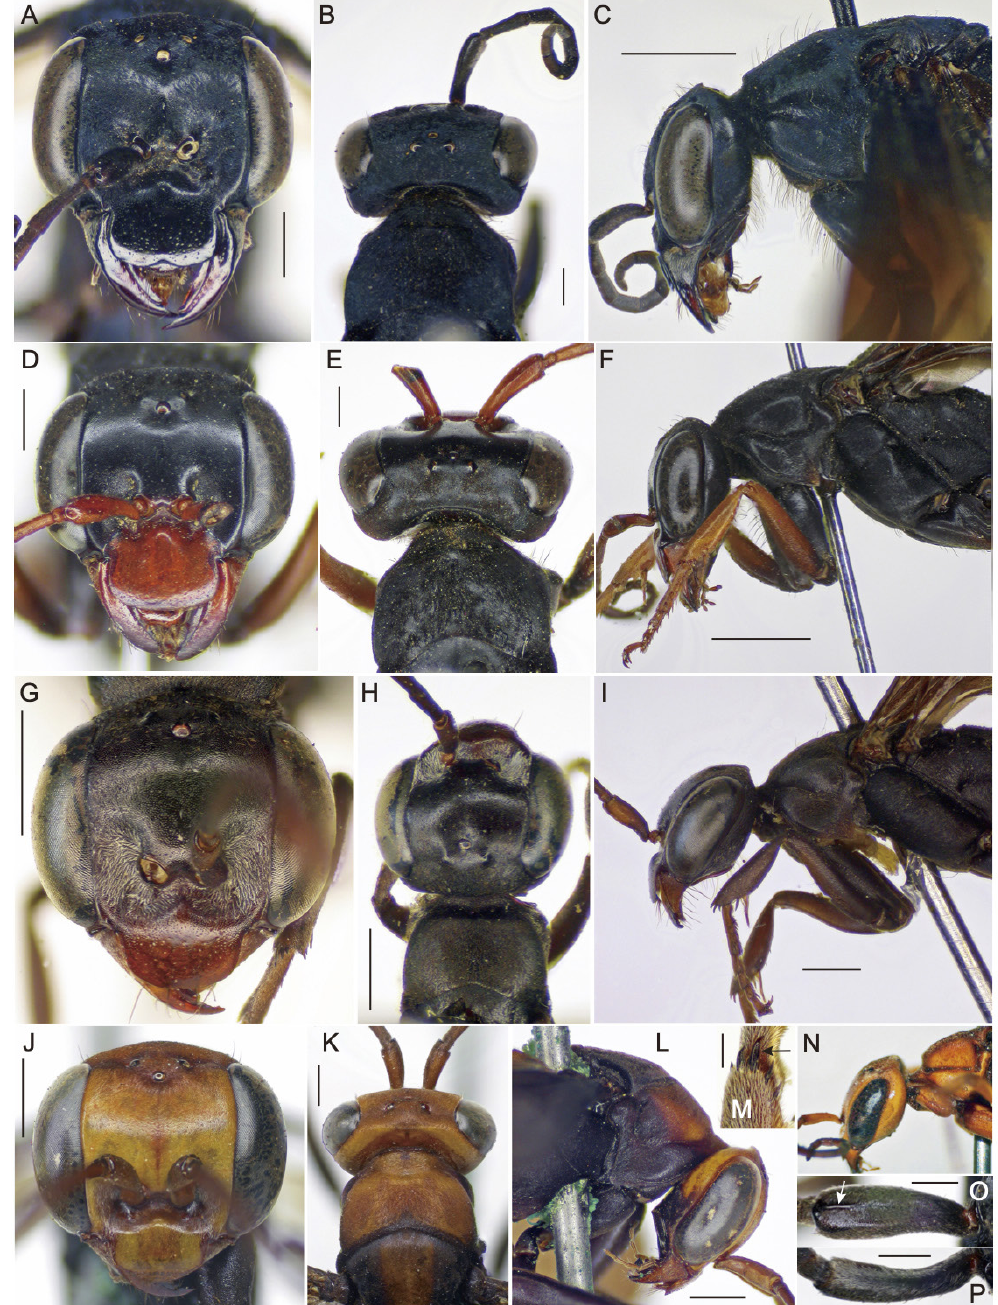
Fig. 6. Females of Paraclavelia Haupt, 1930. A–C, O–P . P. caffer (Kohl, 1886) (#22) (NHMUK). D–F . P. crudelis (Smith, 1879) (#24) (NHMUK). G–I . P. rhodesiensis Arnold, 1832 (#33) (NHMUK). J–M . P. marshalli (Bingham, 1902) (#30) (NHMUK). N . P. somalica Arnold, 1932, holotype (#36) (NHMUK). A, D, G, J . Head, anterior view. B, E, H, K . Head and anterior part of mesosoma, dorsal view. C, F, I, L, N . Head and anterior part of mesosoma, lateral view. M . Apical part of left fore tibia, mesial view, arrow indicates apicomesial spine on fore tibia. O . Right scape, mesial view, arrow indicates longitudinal carina on mesial face of scape. P . Same, dorsolateral view. Numbers in parentheses after species names are specimen numbers in Supp. file 1. Scale bars: A–L = 1 mm; M = 0.2 mm; O–P = 0.5 mm. (N lacks a scale bar because of unavailable measurement data due to lack of access to the